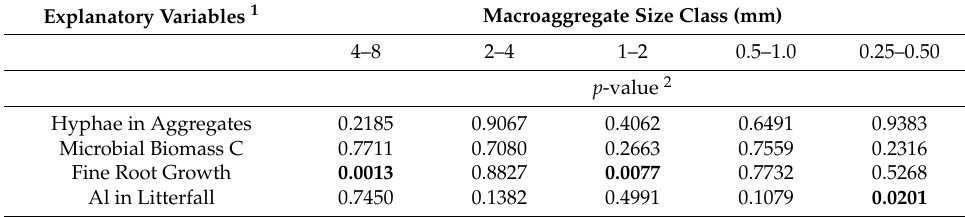
Table 2. Relationships between macroaggregate size fractions (g g -1 dry soil) and four biological factors.